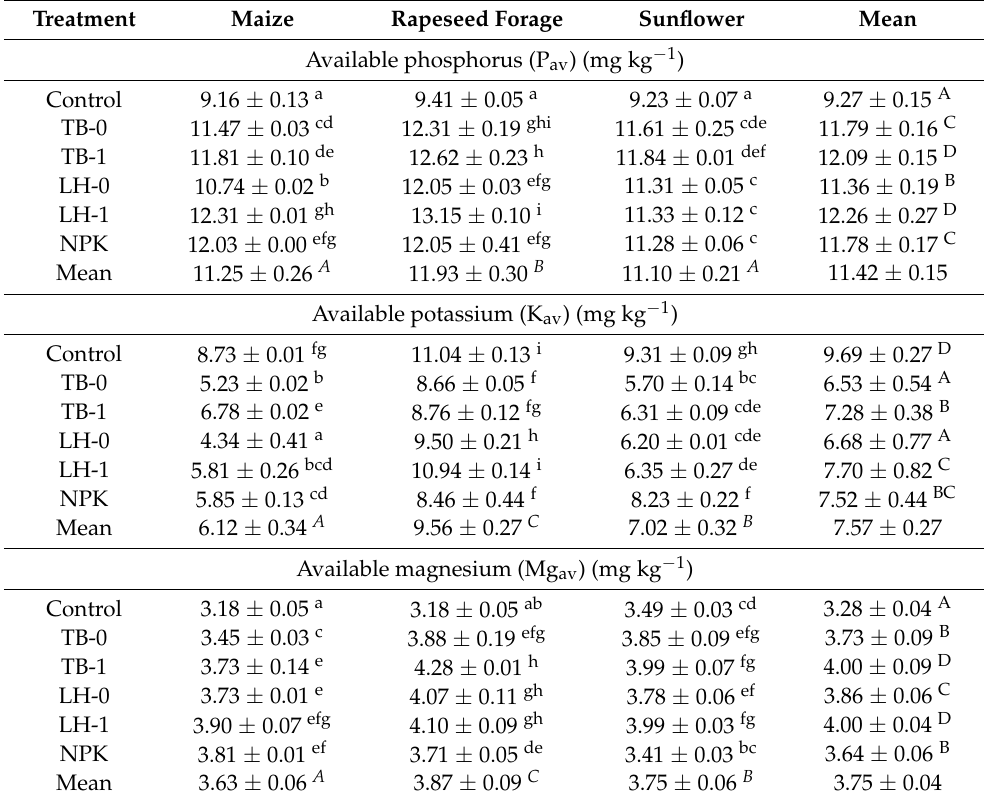
Table 6. The effect of PM application on the content of available forms of macronutrients in the soil after the first year of plant